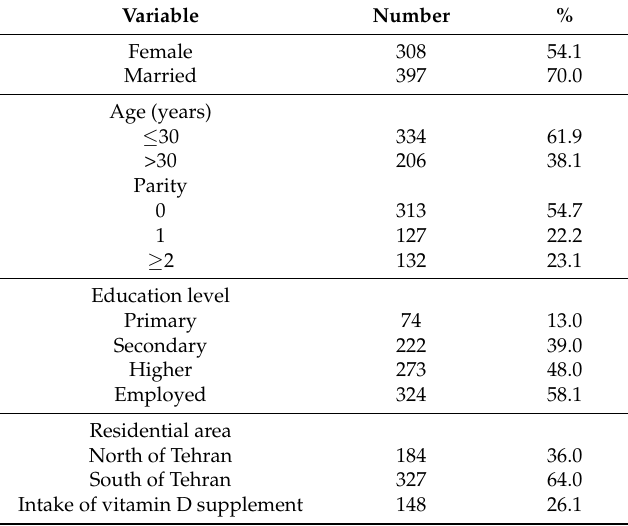
Table 1. Baseline characteristics of the participants ( n =